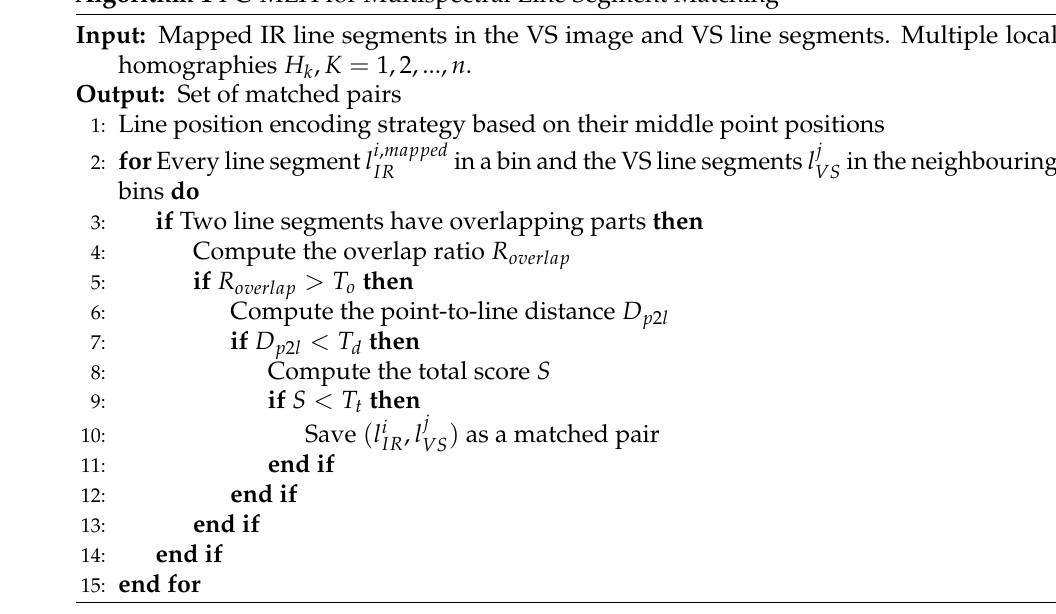
Algorithm 1 PC-MLH for Multispectral Line Segment